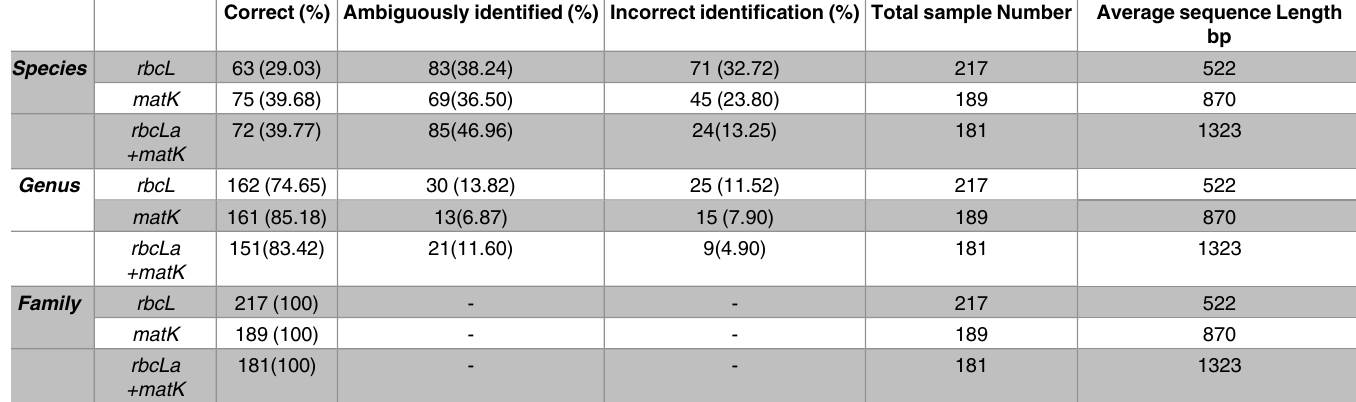
Table 1. Identification successof Egyptian horticultural crops based on Blast1 method. Correct (%) Ambiguously identified (%) Incorrect identification (%) Total sample Number Average sequence Length